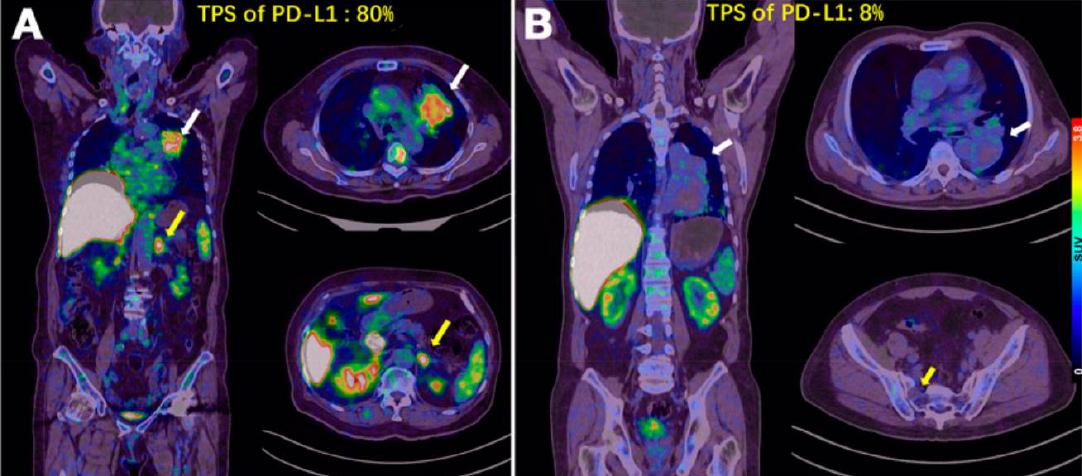
Figure 9. ( A ) An 80-year-old woman with advanced NSCLC and a PD-L1 tumor proportion score (TPS) of 80%. The SUVmax of the primary tumor was 4.87 (white arrow), and that of the left adrenal metastasis was 5.47 (yellow arrow) on [ 68 Ga]Ga-NOTA-WL12 PET. ( B ) A 68-year-old man with a PD-L1 TPS of 8%. The SUVmax of the primary tumor in the left lung (white arrow) and right sacral metastasis (yellow arrow) was 1.84 and 0.8, respectively, on [ 68 Ga]Ga-NOTA-WL12 PET. Reprinted/adapted with permission from Ref. [96]. 2021 by the Society of Nuclear Medicine and Molecular Imaging, Inc.